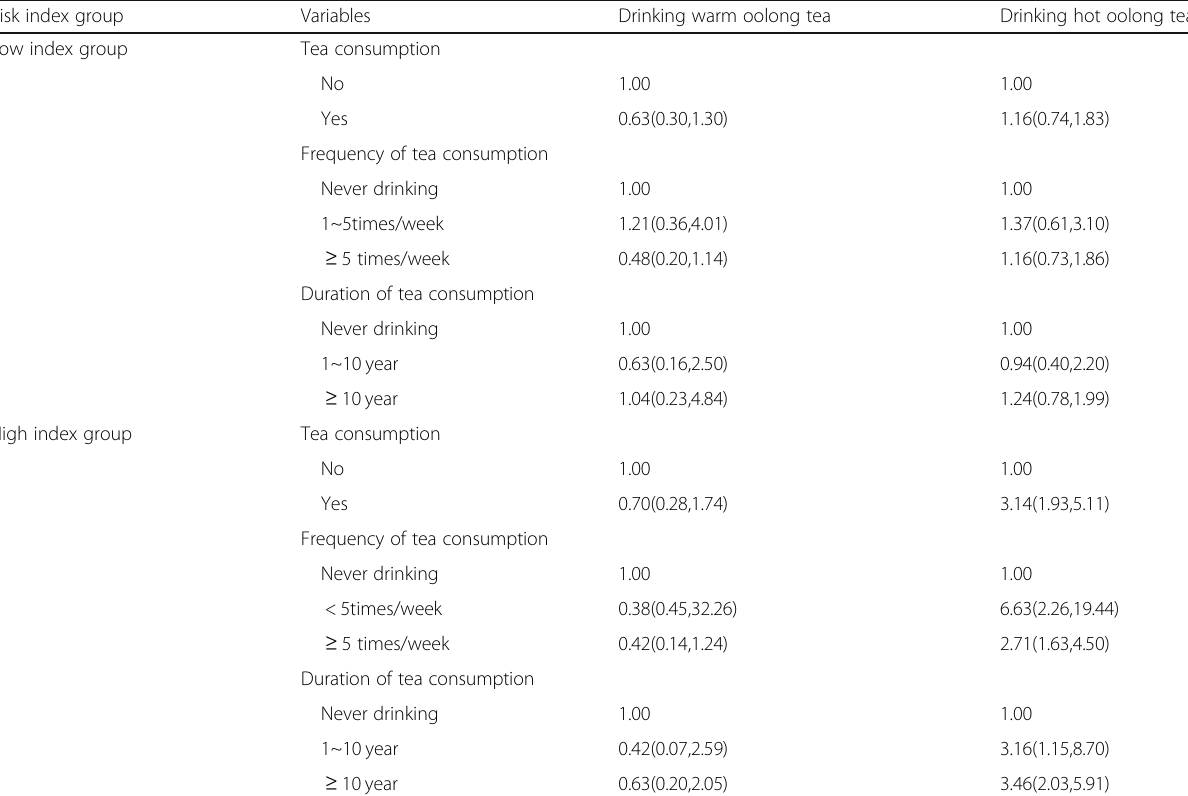
Table 4 The combined effect of the temperature of oolong tea drinking and the risk index group Risk index